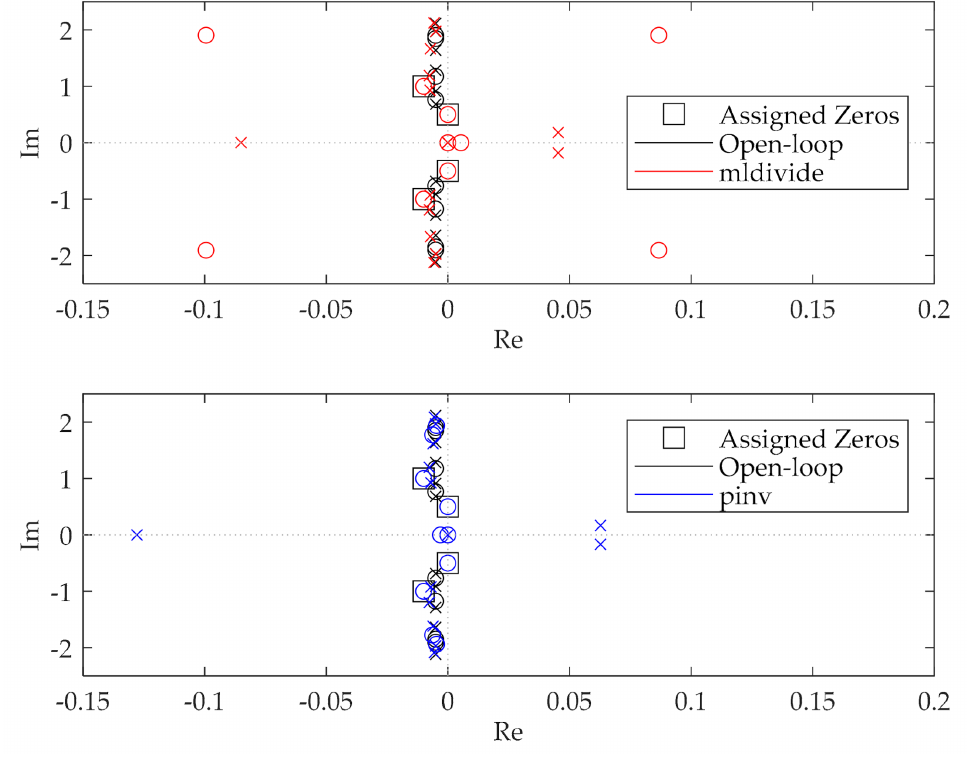
Figure 10. Open-loop and closed-loop pole-zero maps of receptance h 3,4 (j ω ) with different controllers featuring integral